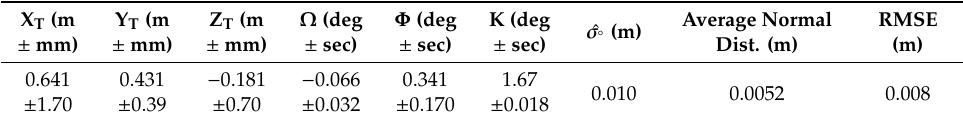
Table 5. Estimated transformation parameters and quality measures (square root of a-posteriori variance factor, average normal distance among point-patch pairs, and RMSE of the normal distances) following the registration of the MLS and TLS point clouds at Site-1.